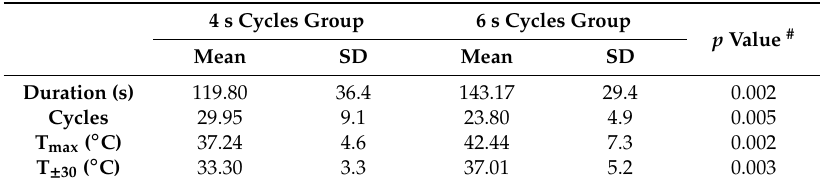
Table 1. Means of the study parameters.